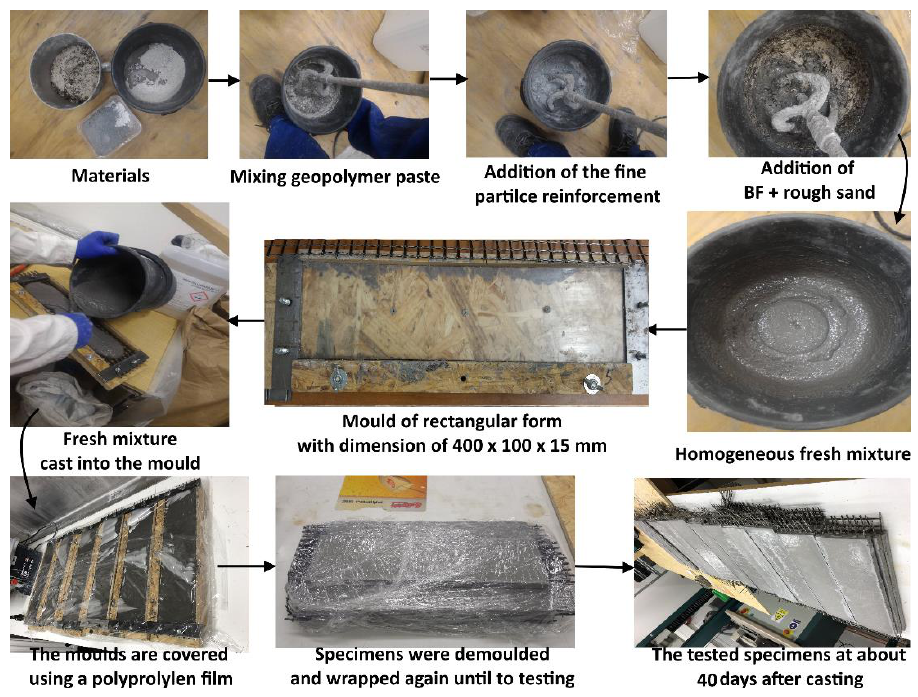
Figure 3. The manufacturing process of basalt textile reinforced specimens.